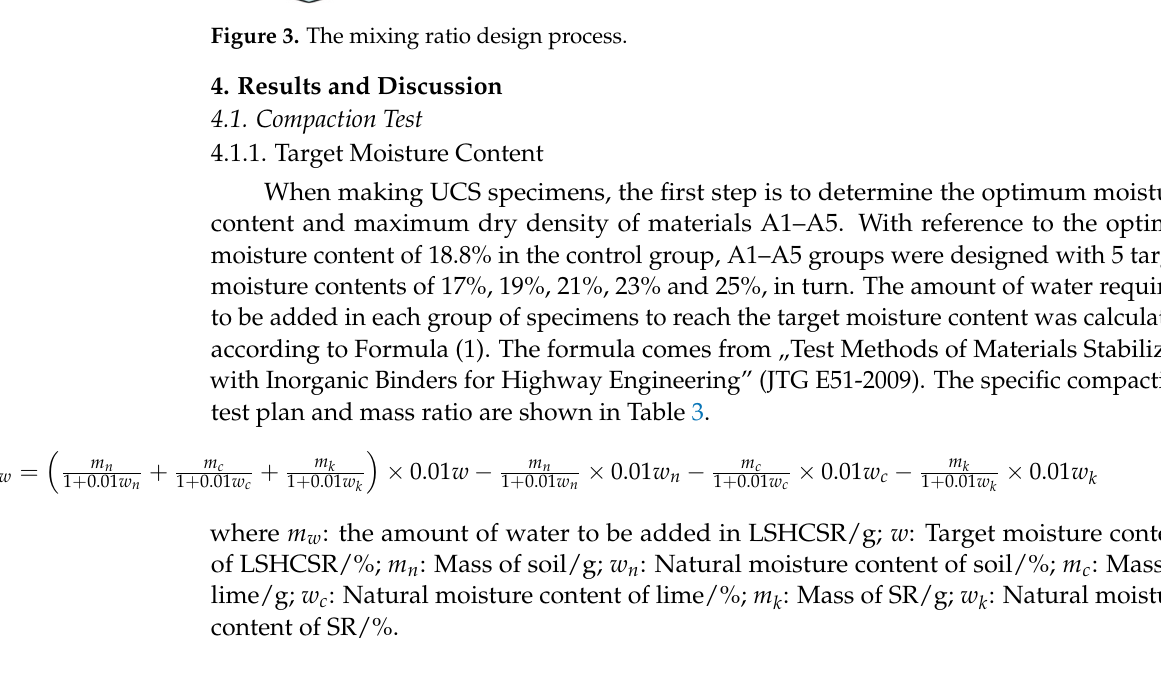
Table 2. Test matching scheme.